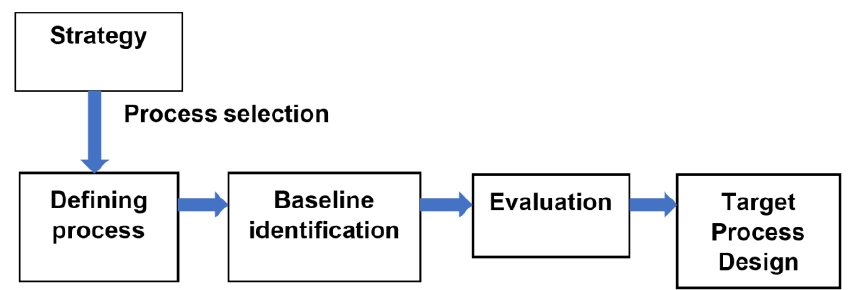
Figure 3. Process analysis and design method (PADM) framework defined by informatics process group (IPG).